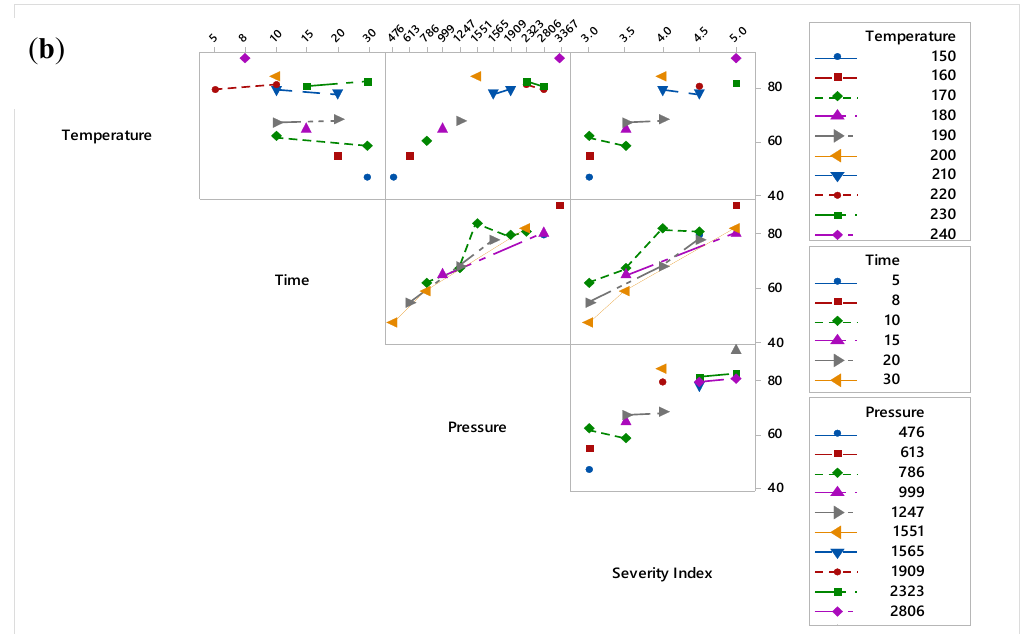
Figure 5. ( a ) The main effect plots of sequential COD solubilization (%) vs. pretreatment temperature (°C), retention time (min), and severity index; ( b ) The interaction plots of HTP temperature (°C), retention time (min), pressure (kPa) and severity index for the overall COD solubilization (%).